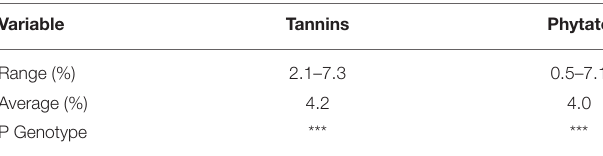
The carbohydrate profile of the Striga -resistant yellow-orange maize hybrids grown at Zaria and Saminaka are presented in Table 3 . Across the two locations, starch content ranged from 40.1 to 88.9%, with an overall mean of 67.2%. Sugar content with an overall mean of 2.7%, ranged from 1.1 to 6.5%; amylose content ranged from 15 to 34.1%, with an overall mean of 23%; while amylopectin content ranged from 65.9 to 85.0%, with an overall mean of 77.0%. The levels of starch, sugar, amylose and amylopectin were significantly ( p < 0.05) affected by hybrid.